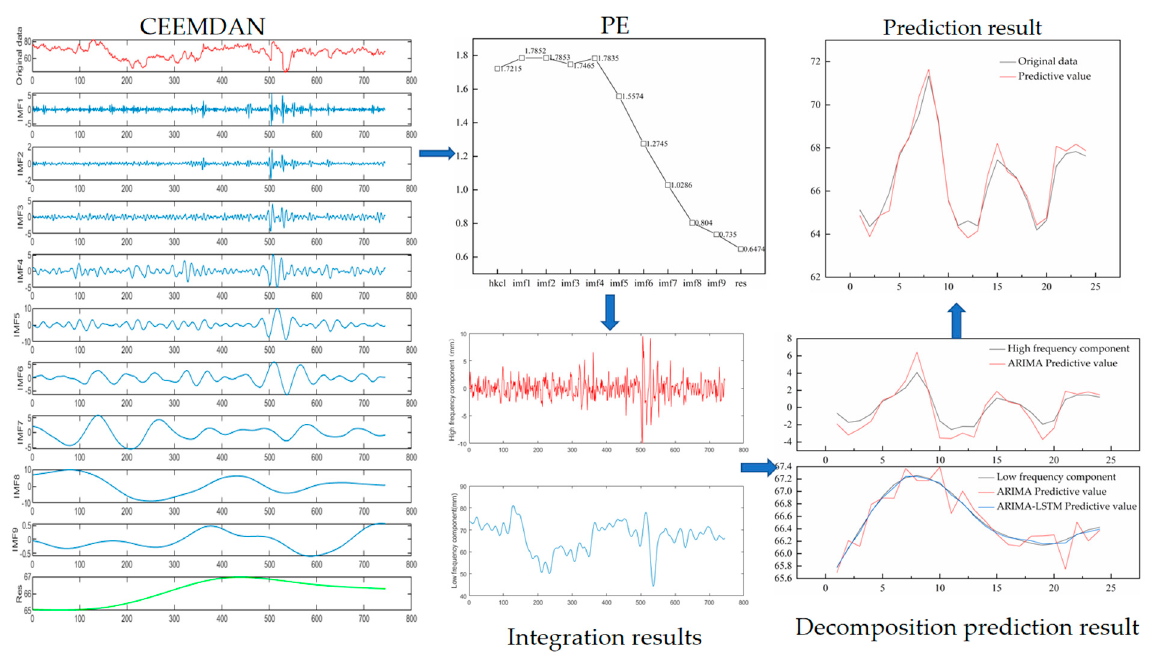
Figure 13. Data prediction process for the HKFN site.